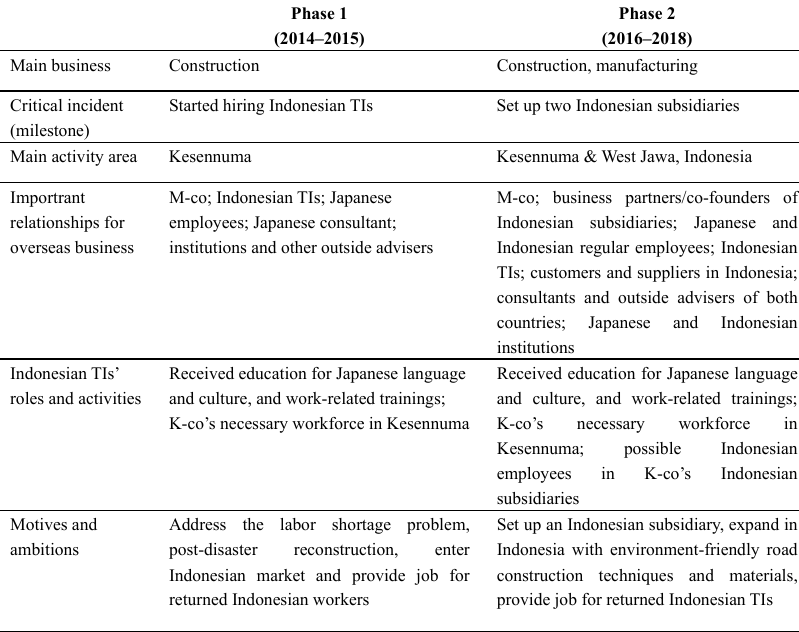
Table 3. K-co’s overseas